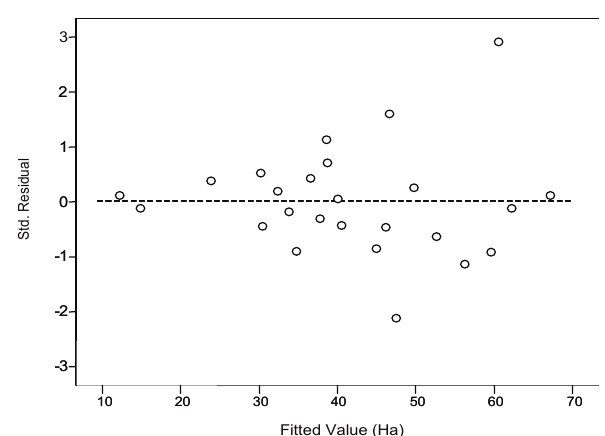
Fig. 6. The relationship between fitted values for area utilised (ha) and the standardised residuals for day journey